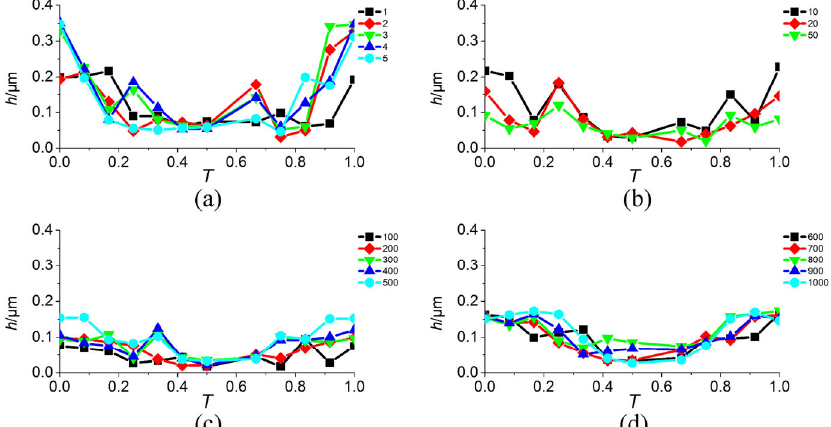
Fig. 18 Variation of central film thickness in some typical working periods ( v max = 0.01 m/s, w = 50 N, T = 0.3 s, L = 0.75